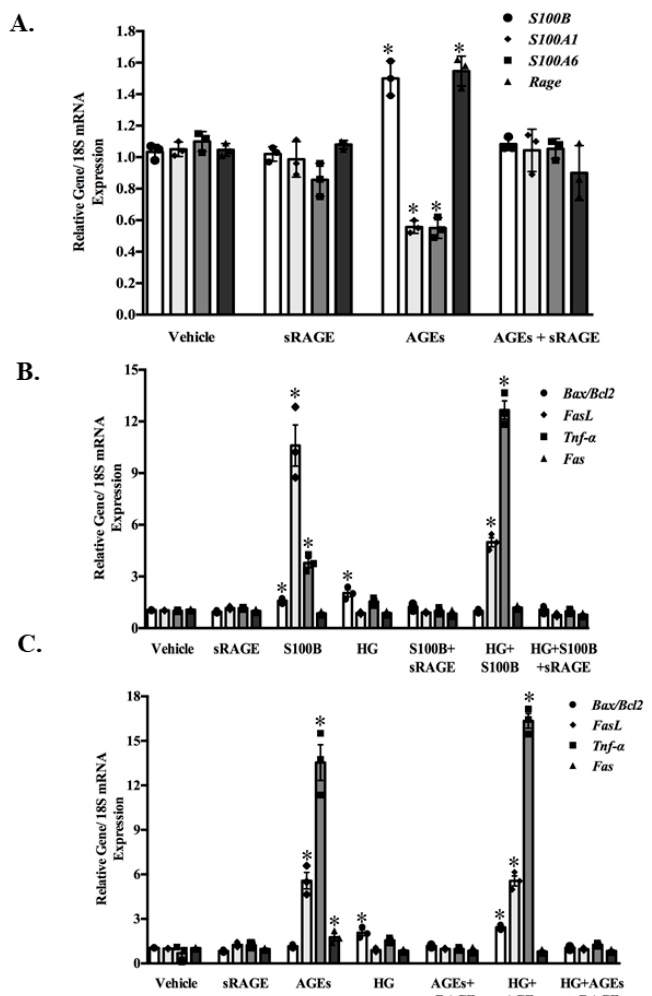
Figure 2. High glucose (HG), AGEs and sRAGE differentially regulate ligands of RAGE ( A ) and parameters of apoptosis (BAX/BCL2 ratio-mitochondrial pathway; FasL, Fas receptor and marker of